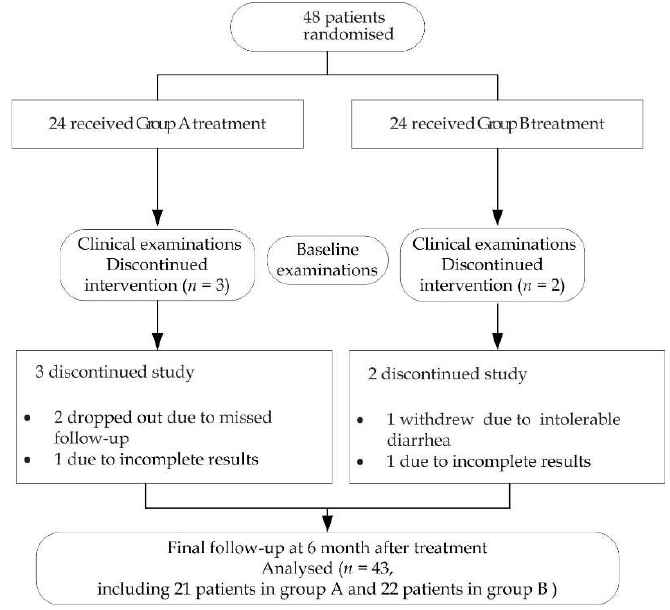
Figure 1. Trial profile. Participants, treatment, and assessment during follow-up. Table 1. General information of patients at baseline (mITT).